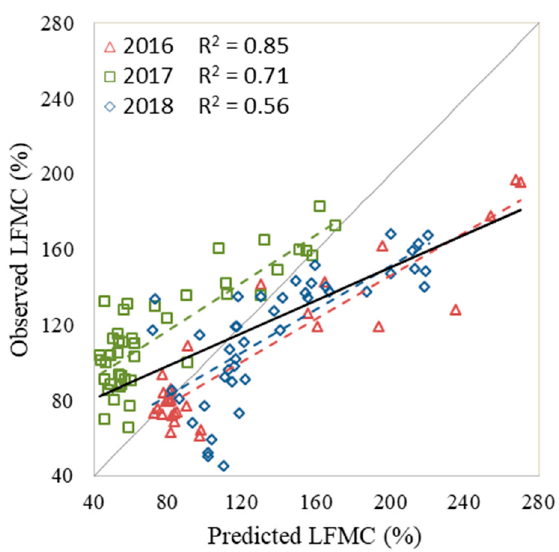
Figure 5. Observed vs. predicted values of LFMC obtained from RTM with correlation lines for the complete dataset (continuous black) and each year (dashed color lines).